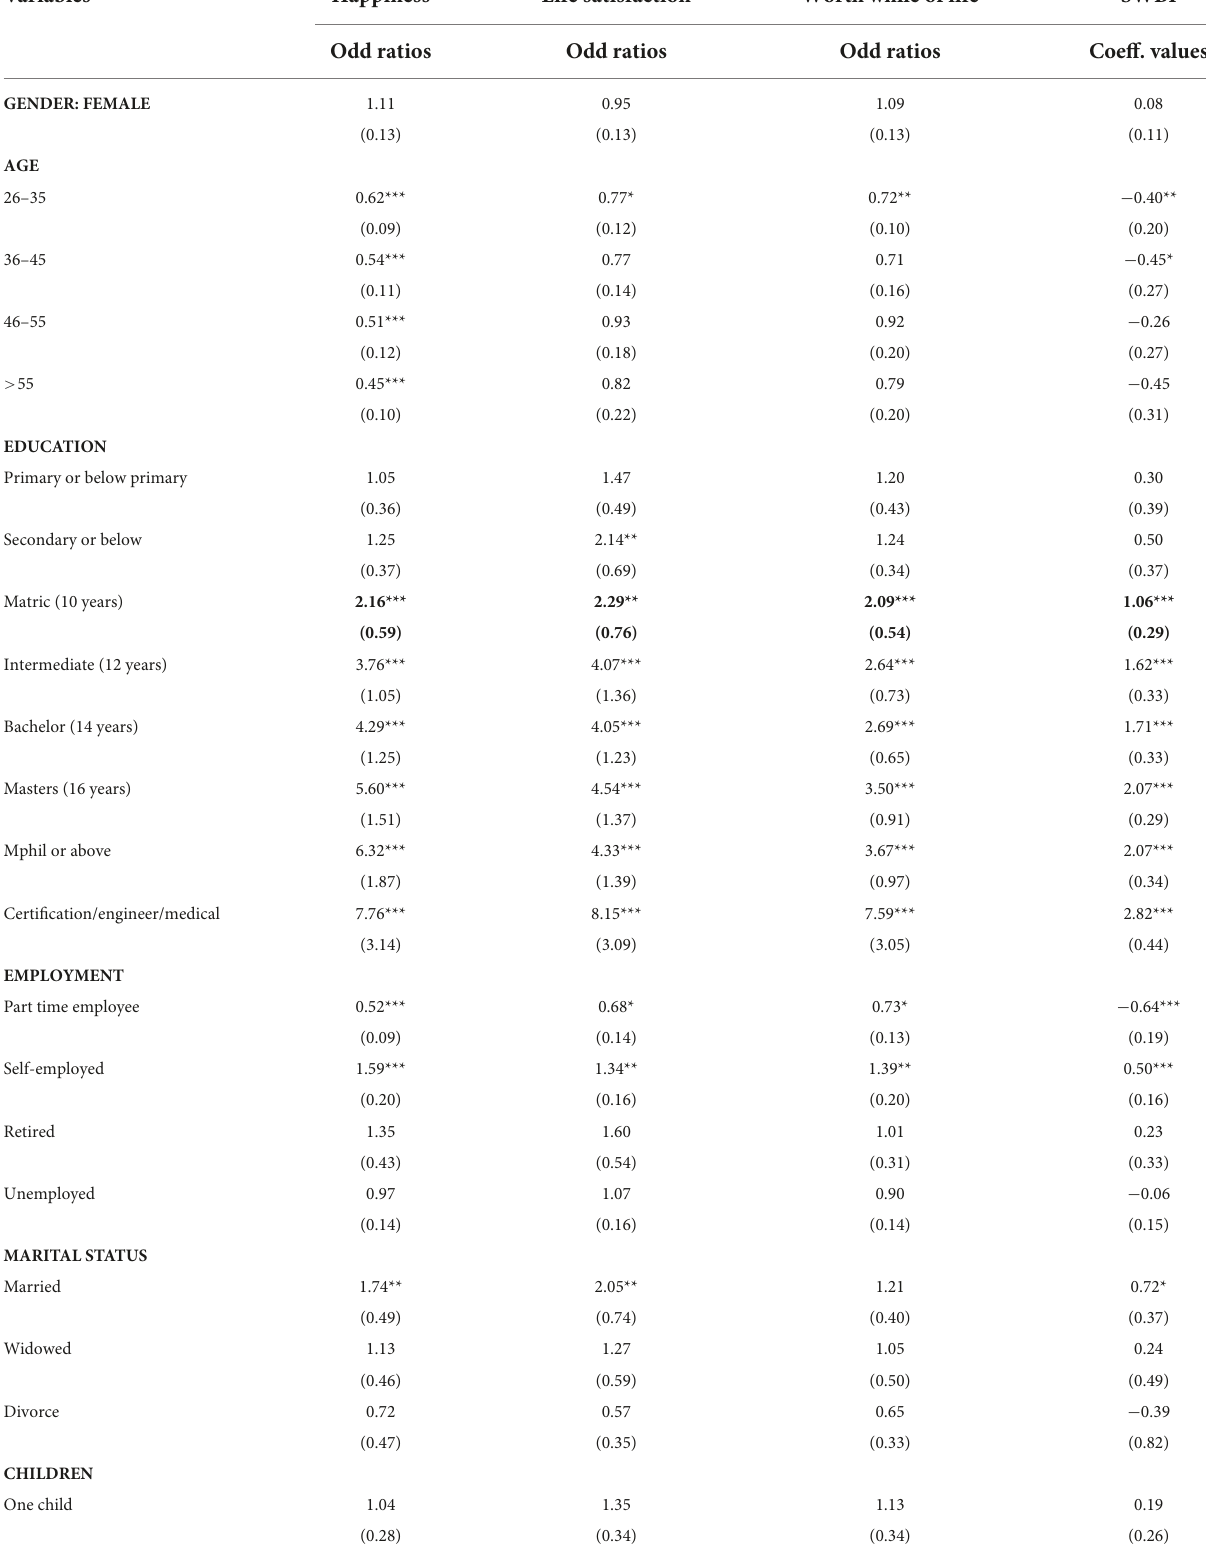
TABLE 4 Demographic determinant of subjective wellbeing method: Ordered logit and tobit [only for subjective wellbeing index (SWBI)]. Variables Happiness Life satisfaction Worth while of life SWBI Odd ratios Odd ratios Odd ratios Coeff.